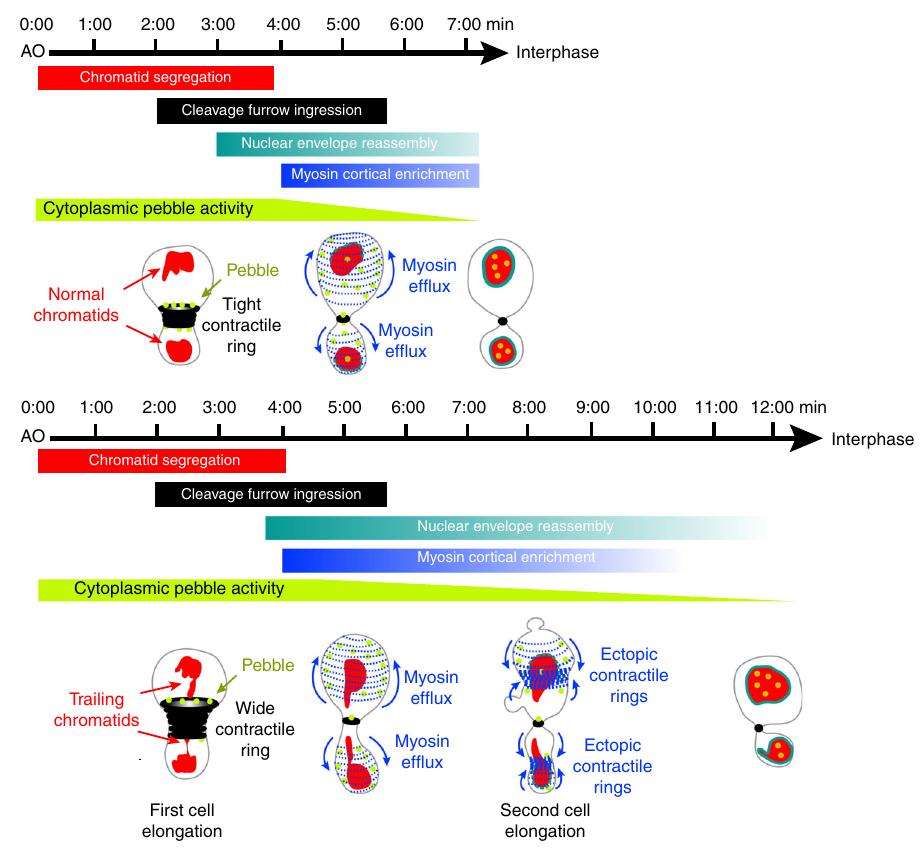
Figure 7 Model for cell elongation in the presence of trailing chromatids. The top and bottom panels illustrate key mitotic exit events in cells with normal ( NC ) and trailing chromatids ( TC ), respectively, from anaphase onset ( AO ). The red , black , cyan , and blue rectangles represent the average duration of chromatids poleward movement, cleavage furrow ingression, nuclear envelope reassembly ( NER ), and myosin cortical enrichment, respectively. The rectangles are timely positioned with respect to AO. The variability in the duration of NER and myosin ef fl ux is symbolized by color fading at the extremities. The green shape symbolizes putative pebble cytoplasmic activity throughout mitotic exit. The schemes illustrate the state of the four events listed above at key moments during mitotic exit. Three minutes after AO, Pbl ( green dots ) concentrates at the midzone where a tight contractile ring ( black circles ) assembles when chromatids ( red ) have segregated to the poles. The presence of trailing chromatids at the midzone favors the assembly of a wide ring, whose contraction generates the fi rst cell elongation. Next, myosin initiates Pbl-mediated ef fl ux and invades the polar cortex ( blue dashed thin curves ) while nuclear envelope starts reassembling on the chromosome mass at the poles ( cyan dashed lines ). In control cells, myosin disassembles from the polar cortex upon completion of NER ( cyan lines ), 7 min, on average, after AO. The presence of TC near the midzone induces a severe delay in NER completion. Consequently, the delay in Pbl nuclear import prolongs active cortical myosin, which reorganizes into ectopic lateral rings ( blue dashed thick curves ). The partial contraction of the rings promotes the second phase of elongation, allowing the clearance of the trailing chromatids from the cleavage plane. Myosin dissociates from the cortex upon completion of NER 12 min, on average, after